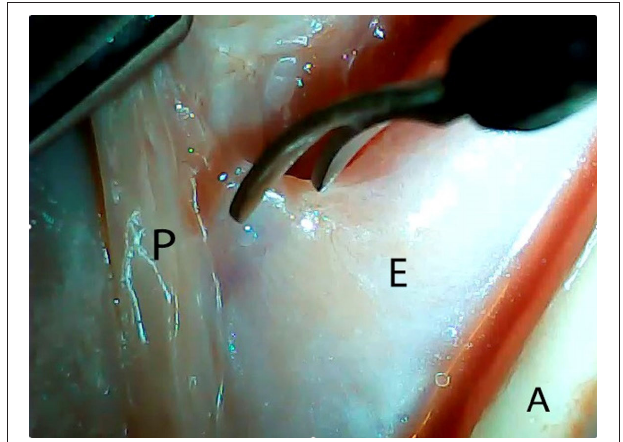
FIGURE 1 | Thoracoscopic mobilization of the middle third of porcine esophagus. P, parietal pleura; E, esophagus; A, aorta.